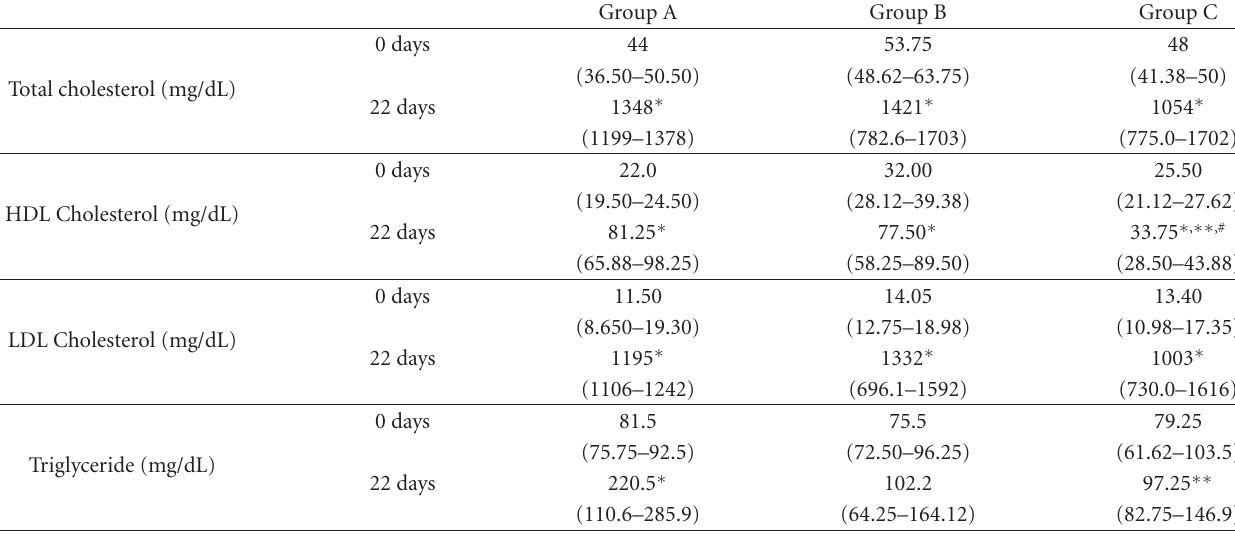
Table 3: Lipid profile of experimental